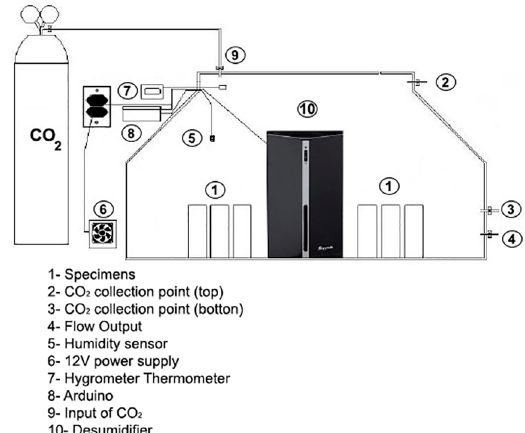
Figure 1. - Schematic of the carbonation chamber. Adapted from Martins et al . 19 with